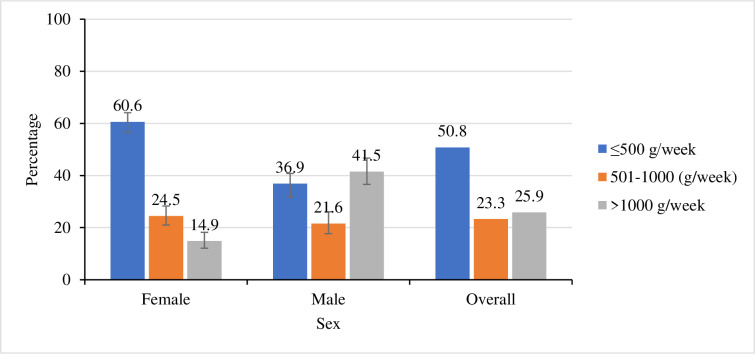
Percentage of the level of red meat consumption by sex.The Observed difference between sexes was statistically significant at p<0.001.